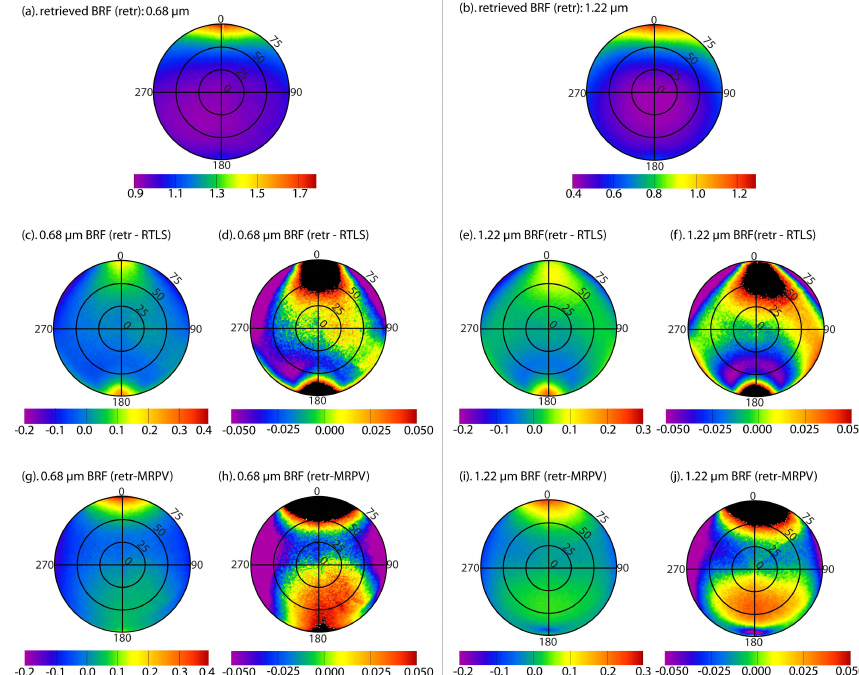
Fig. 5. Retrieved snow BRF and accuracy of RTLS and MRPV models at 0.67µm and 1.22µm wavelength, for 7 April flight over Elson Lagoon. The accuracy, computed as ( ρ − ρ Model ) , is shown for the full range (on the left) and for a reduced range ( ± 0.05, on the right) of values.